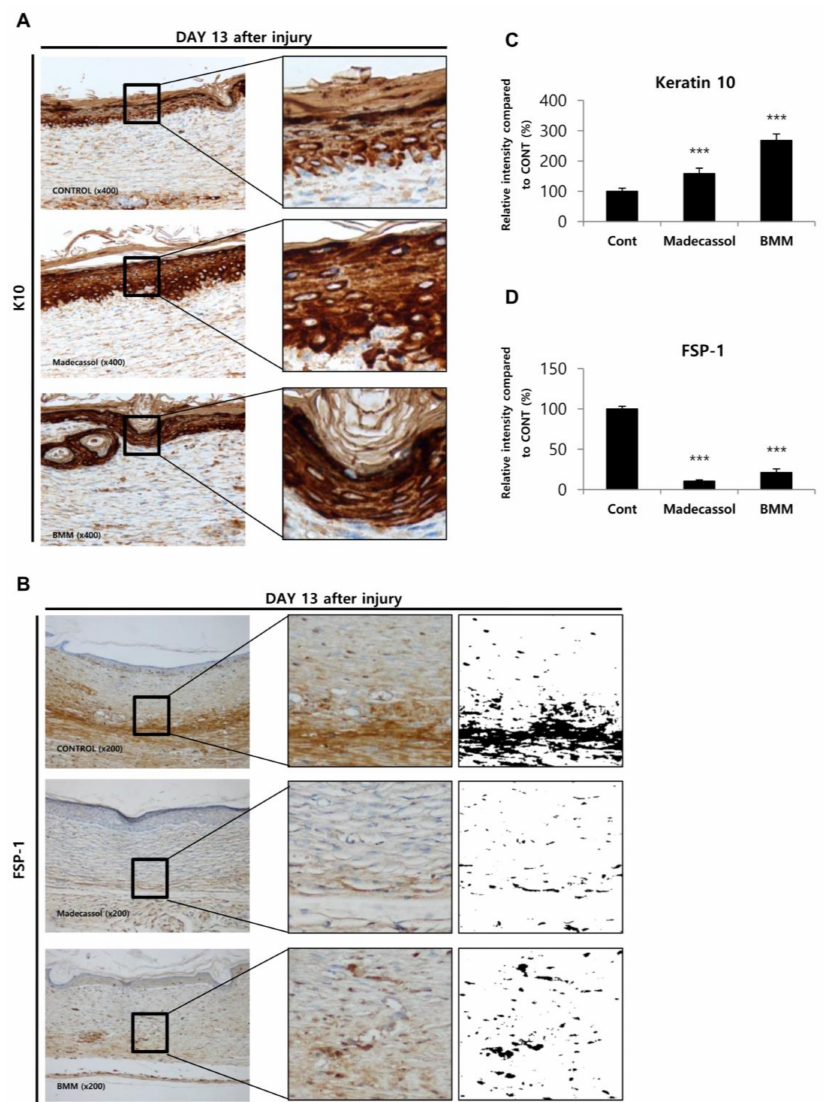
Figure 7. The epithelial restoration and anti-scarring effect of BMM in the late phase of wound healing. ( A , B ) Immunohistochemical staining of skin tissue isolated from the wound site on indicated days; ( C , D ) Intensities of K10-positive epithelial cells and FSP1-positive fibroblast cells were measured using the ImageJ software. “Control” indicates butylene glycol and “Madecassol” was used as a positive control. *** p < 0.001 as compared to the